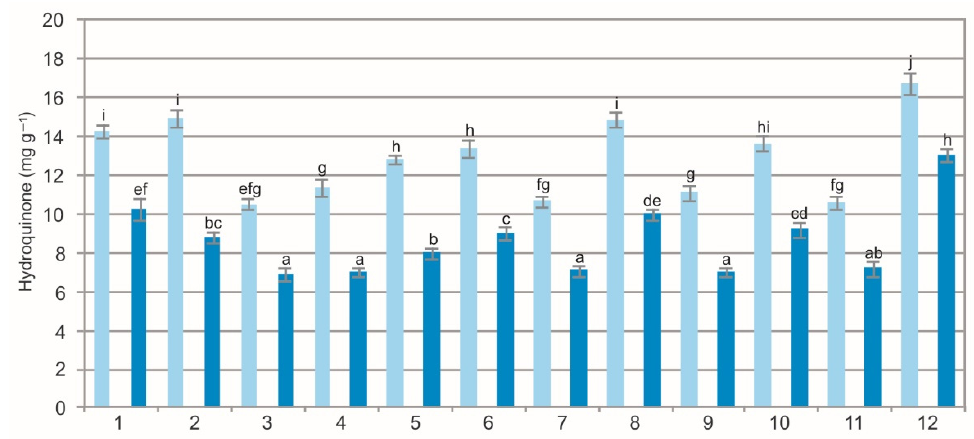
Figure 4. Hydroquinone concentration in water (light blue) and ethanol (dark blue) leaf extracts from bearberry plants in different populations. The values designated by the different letters are significantly different ( p < 0.05).